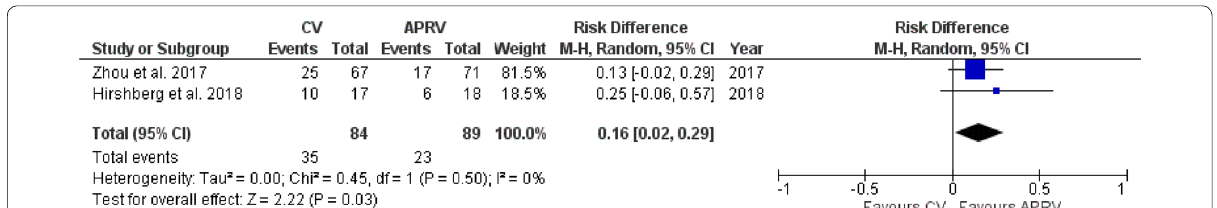
Fig. 4 Hospital mortality. APRV airway pressure release ventilation, CV conventional ventilation